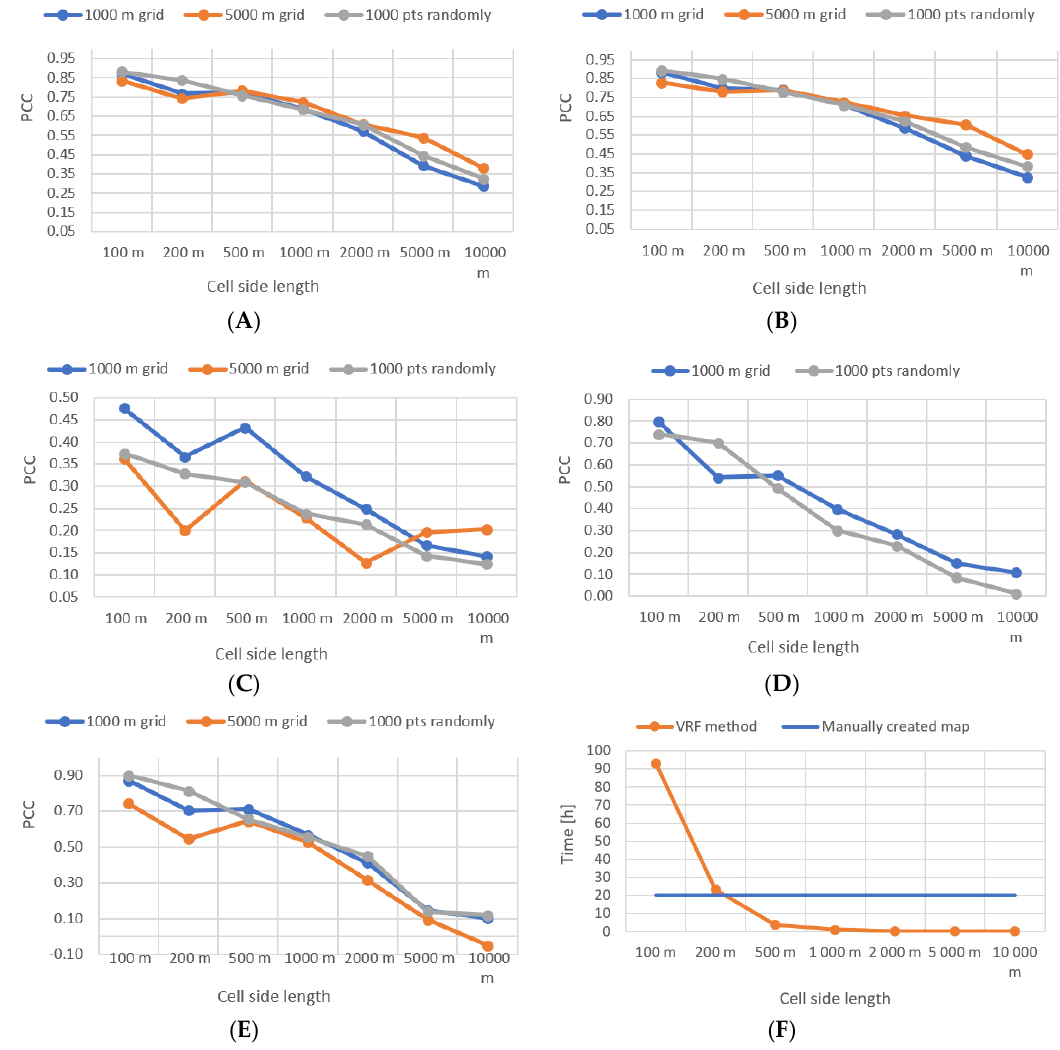
Figure 16. Correlation between the values of statistical parameters and cell size. ( A ) Correlation between PCC and cell size in terms of total IOP; ( B ) Correlation between PCC and cell size in terms of vegetation; ( C ) Correlation between PCC and cell size in terms of relief; ( D ) Correlation between PCC and cell size in terms of buildings; ( E ) Correlation between PCC and cell size in terms of hydrography; ( F ) Correlation between map generating time and cell size.